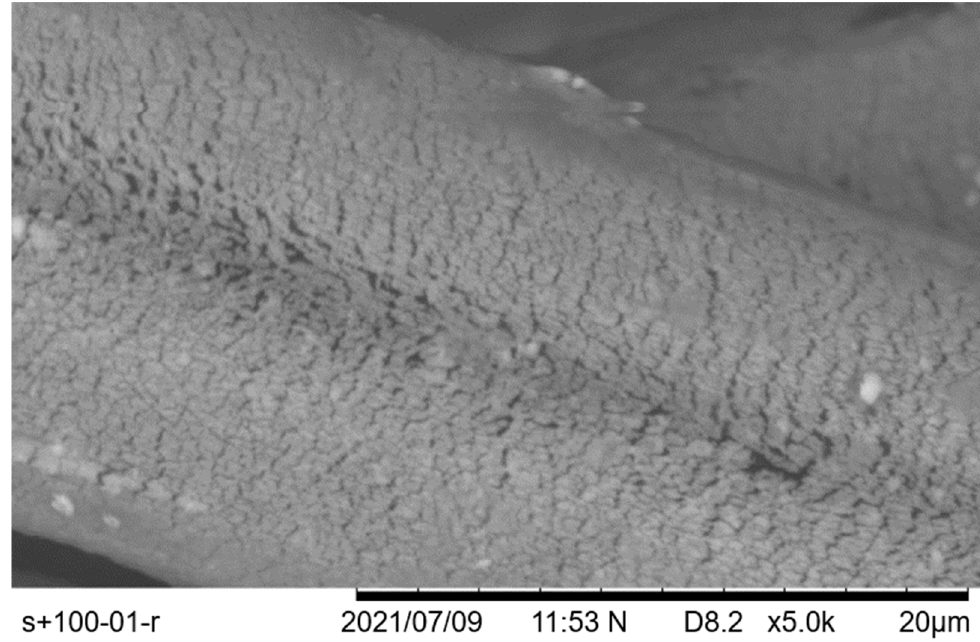
Figure 6. SEM imaging of Silver-tech+ 100 threads after tensioning to the level of permanent elonga- tion, with visible microfractures of the silver coating.